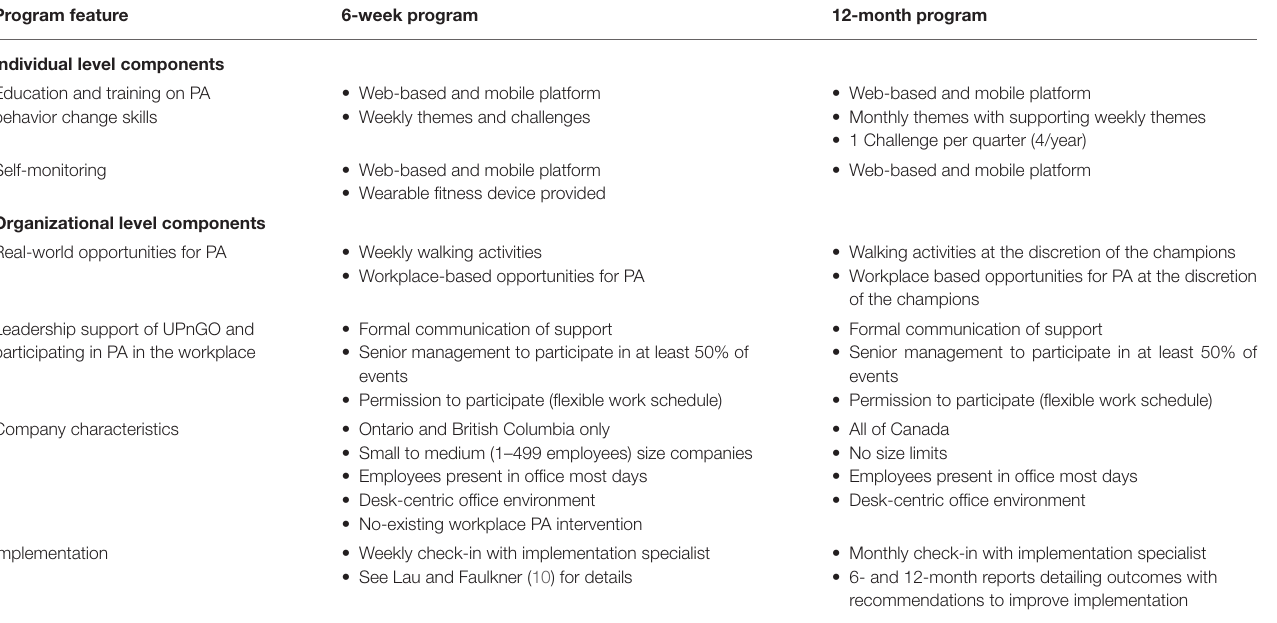
TABLE 1 | Scaling-up